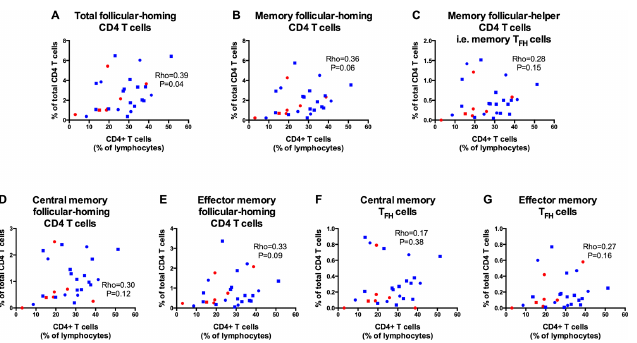
Fig 2. In the HIV-infected cohort, proportions of total follicular-homing CD4 T cells are directly correlated with CD4 percentages. Correlation analysesbetweenCD4 T cells (as percentage of total lymphocytes) and: (A) total follicular-homingCD4 T cells (CXCR5 + CD4 + ), (B) memory follicular-homingCD4 T cells (CXCR5 + CD45RO + CD4 + ), (C) memory T FH cells (CXCR5 + CD45RO + PD1 + CD4 + ), (D) central memory follicular-homingCD4 T cells (CXCR5 + CD45RO + CCR7 + CD4 + ), (E) effector memory follicular-homing CD4 T cells (CXCR5 + CD45RO + CCR7 - CD4 + ), (F) central memory T FH cells (CXCR5 + CD45RO + PD1 + CCR7 + CD4 + ) and (G) effector memory T FH cells (CXCR5 + CD45RO + PD1 + CCR7 - CD4 + ). Circles represent highly viremic childrenand squares representlowly viremic children. Red symbols represent HAART-na ï vechildren and blue symbols represent HAART-treated children.Statistical test: Spearman’srank-ordercorrelation.